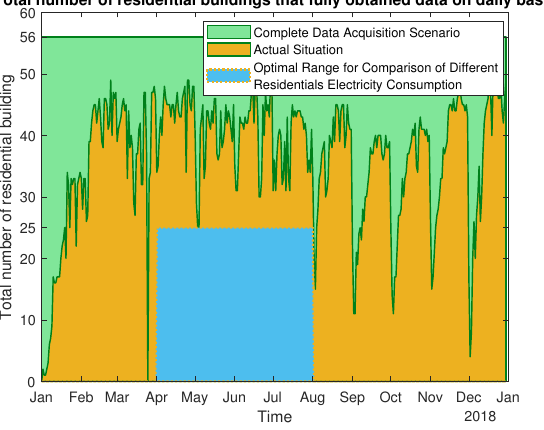
Figure 3. The optimal range for comparison of different household’s daily electricity consumption.